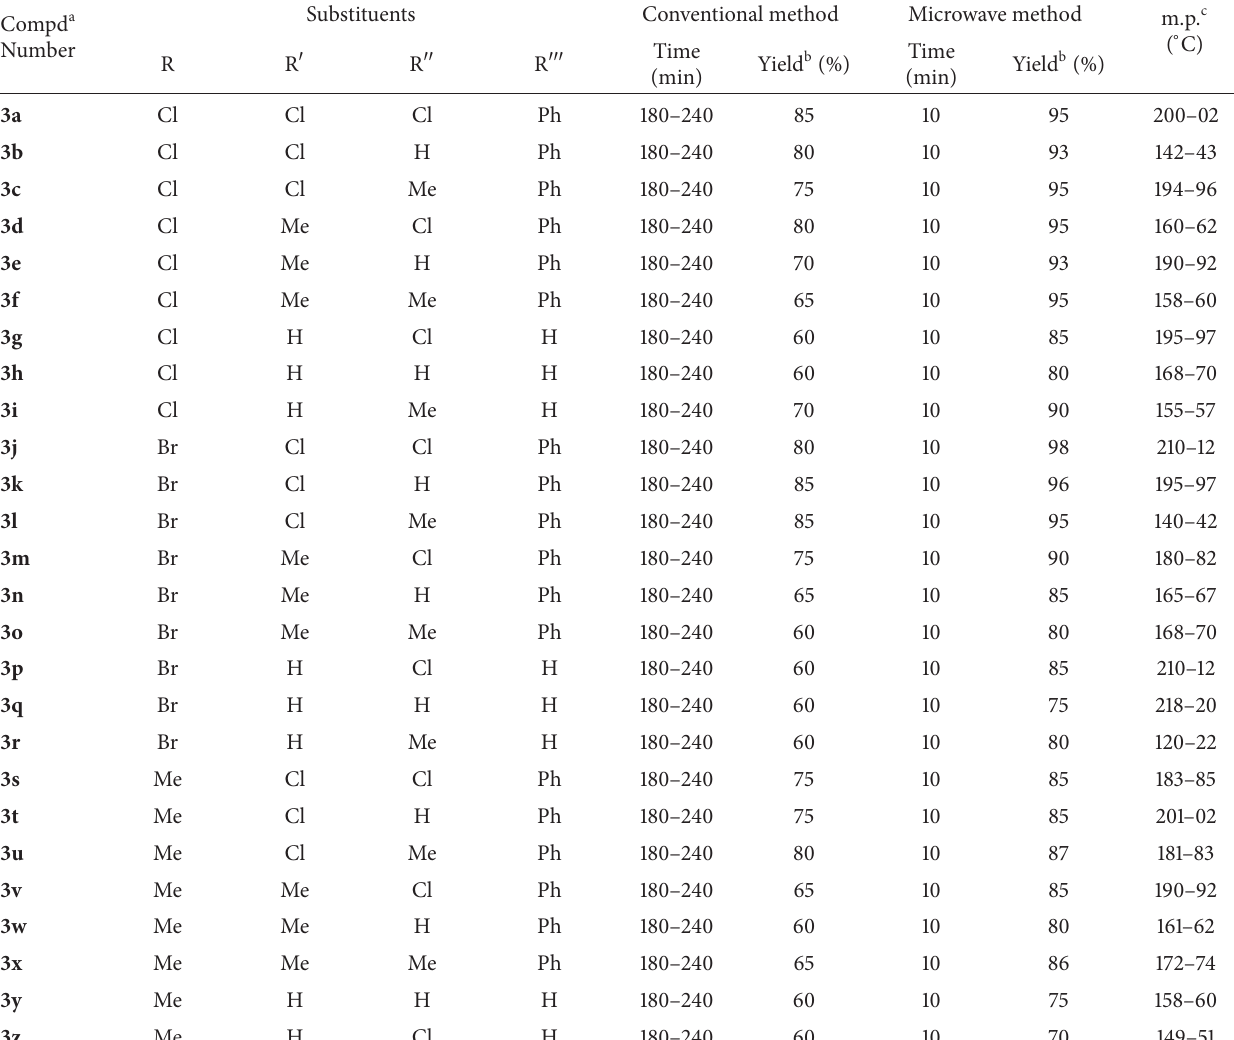
Table 1: Comparative data of conventional and microwave methods for the synthesis of novel triazolothiadiazepinylindole 3a–z . Compd